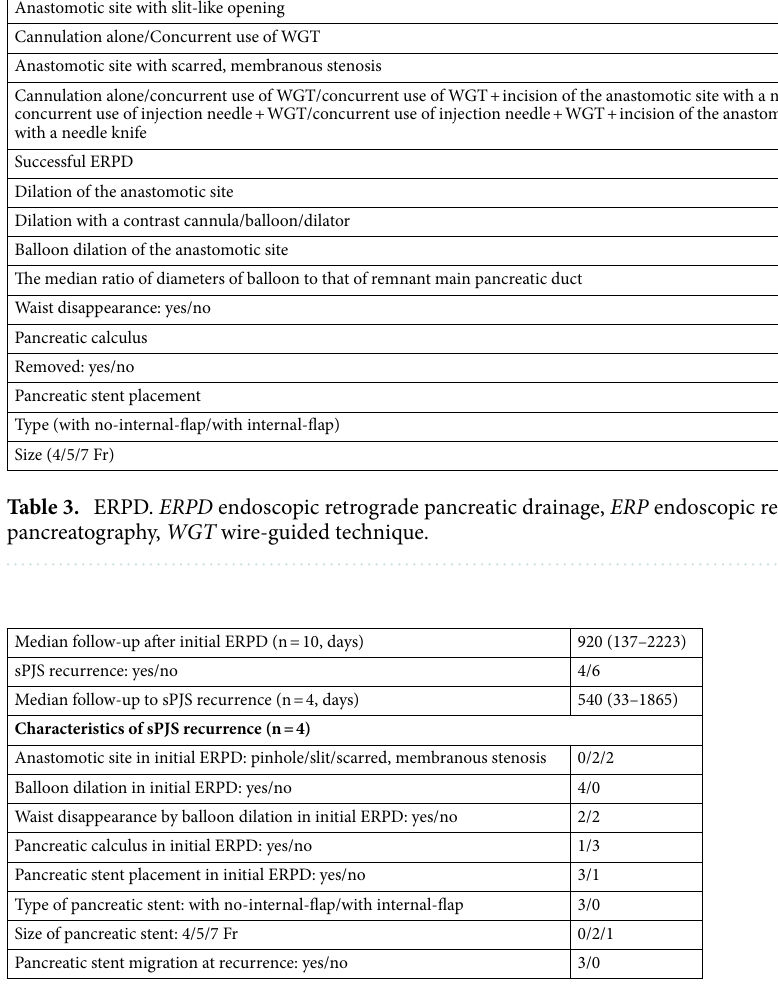
Table 4. Recurrent sPJS after ERPD. sPJS symptomatic pancreaticojejunal anastomotic stenosis, ERPD endoscopic retrograde pancreatic